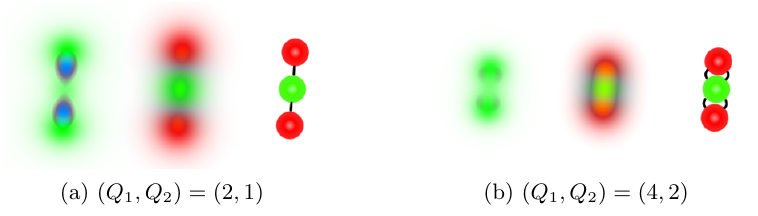
Figure 7 : ( Q 1 ; Q 2 ) = (2 Q; Q ) minimal vortex \pills", with Q = 1 ; 2. Each sub(cid:12)gure contains 3 elements from left to right: an energy density plot, a (cid:12)eld density plot and a sketch of how the red and green vortices are interconnected. The (cid:12)rst two plots are made using the coloring scheme of (cid:12)gure 2.